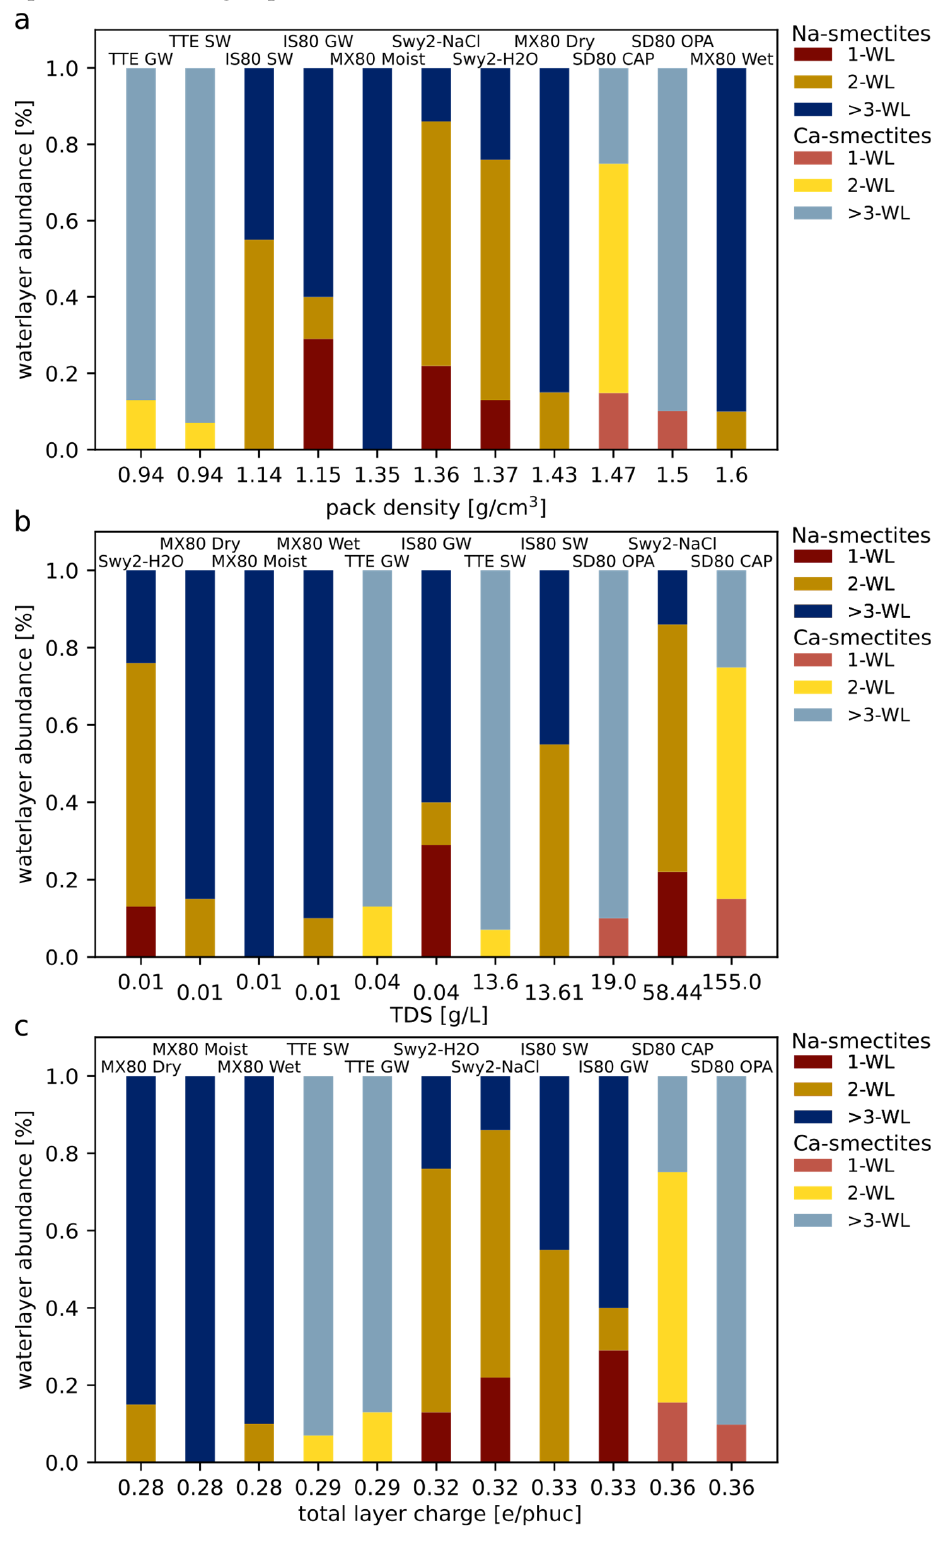
Figure 7. Summary of the number of water layers developed in hydrated bentonite samples studied by wet-cell X-ray diffractometry [9,22,30]. ( a ) water uptake verses packing density, ( b ) water uptake verses total dissolved solids (TDS), ( c ) water uptake verse total layer charge.